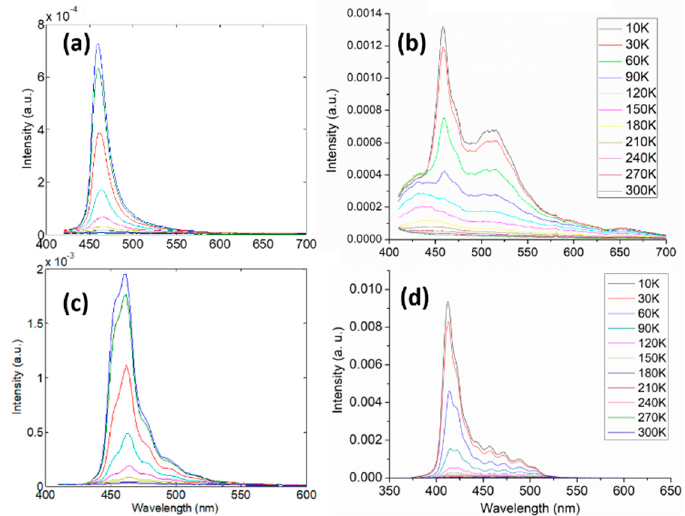
Figure 4. Temperature-dependent photoluminescence (PL) spectra of samples ( a ) SI27, ( b ) CSI27, ( c ) PIN27, and ( d ) PIN15.